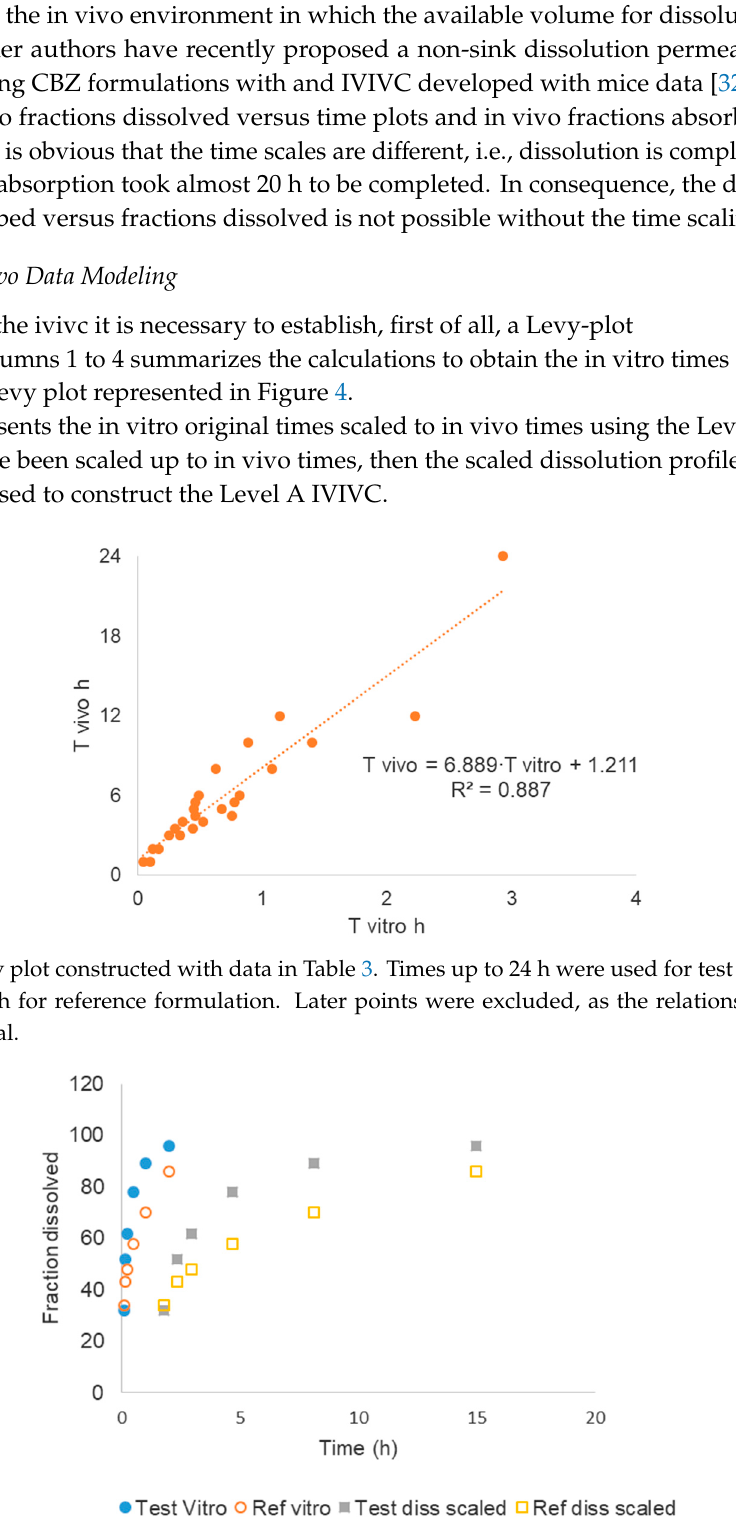
Figure 5. Dissolution profiles in their original in vitro time scale and scaled to equivalent in vivo times